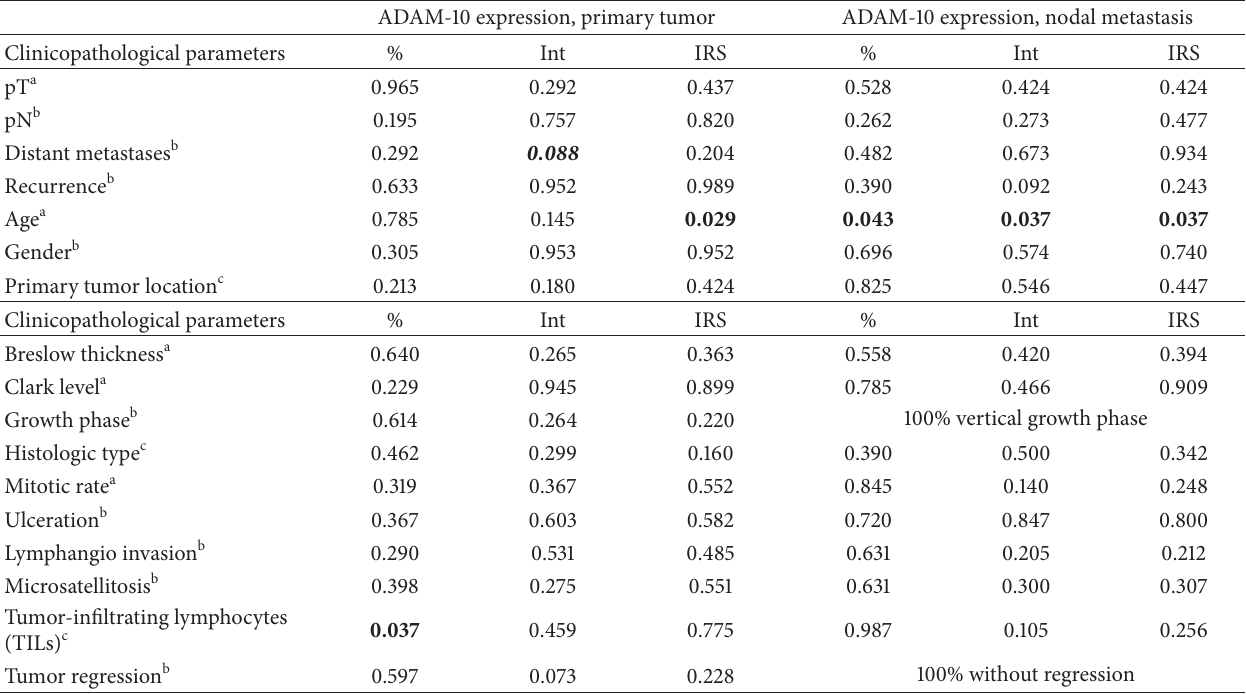
Table 3: Correlations between clinicopathological and histopathological characteristics and ADAM-10 expression parameters in primary tumors and nodal